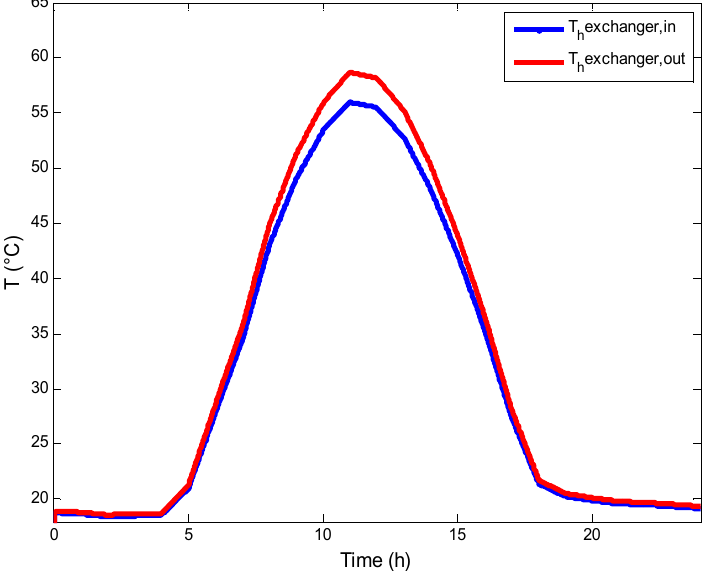
Figure 9. Variation of saline water temperatures at the level of a plate heat exchanger with time.